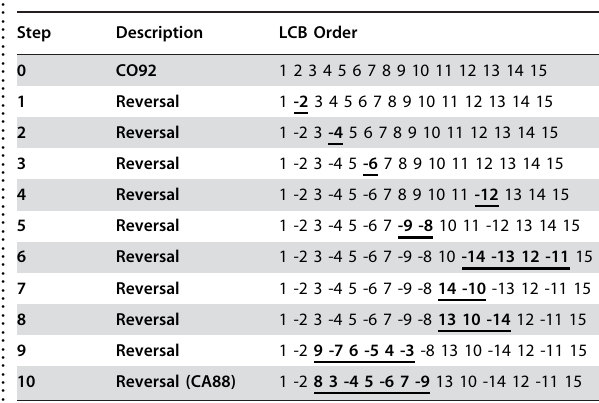
Table 3. Output from GRIMM showing the most